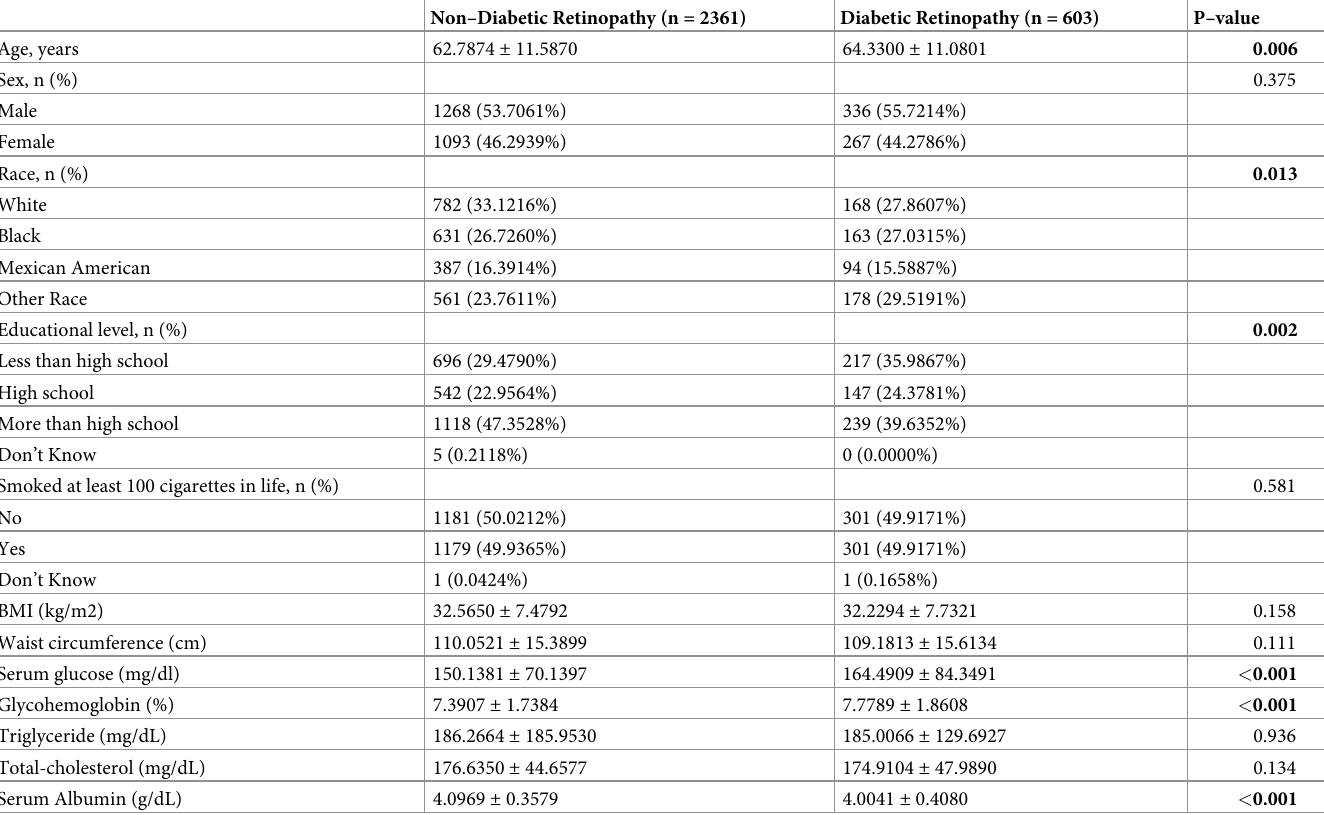
Table 1. Characteristics of study sample with and without diabetic